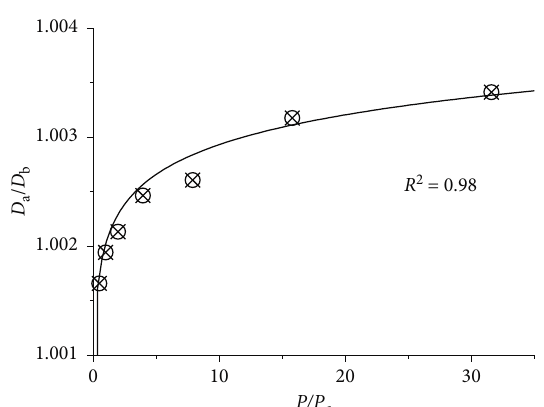
0.01 Figure 8: The diagram of Einav’s relative